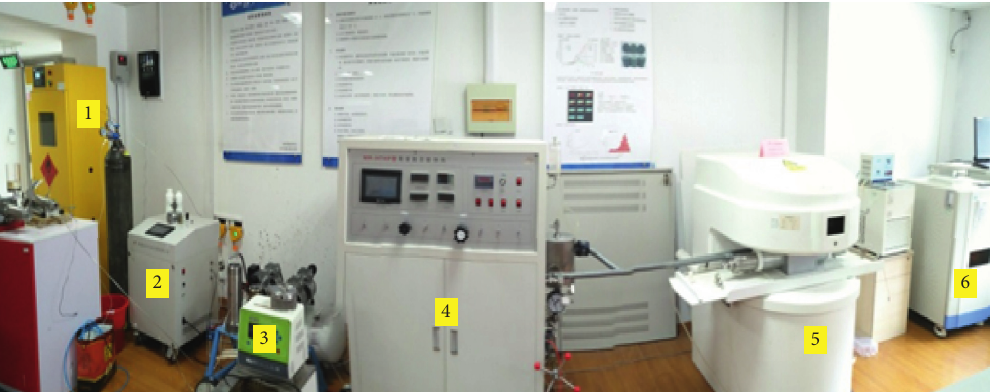
Figure 1: Analysis and imaging systems of coal structure and gas seepage: (1) displacement device; (2) middle container; (3) transition device, which may contain water, oil, and gas; (4) high-temperature and high-pressure system; (5) nuclear magnetism unit; and (6) closet, which mainly includes radio frequency cabinet, gradient cabinet, and imaging module.